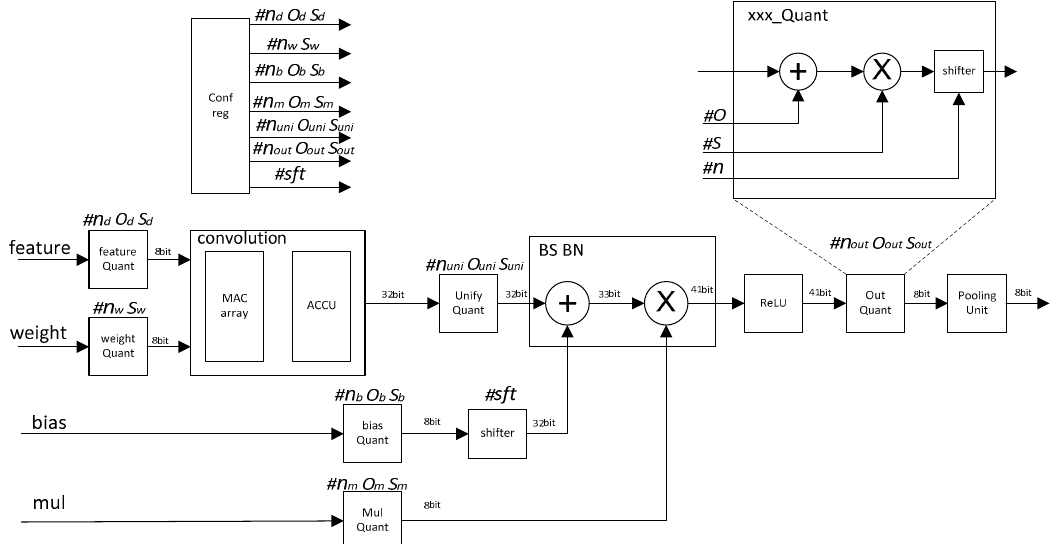
Figure 1. Integer quantization CNN accelerator architecture diagram.